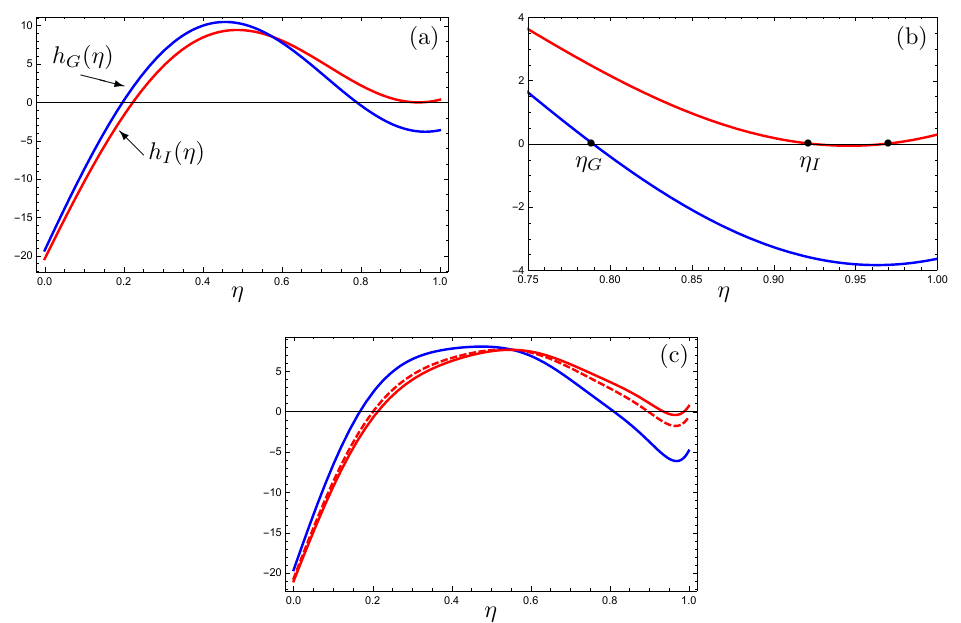
Figure 2. Plots of h G (blue) and h I (red), where the diffusion coefficients satisfy D G < D I . ( a , b ) N = 1, D G = 0.3, D I = 0.394; ( c ) N = 3, D G = 0.3 (blue), D I = 0.394 (dashed), D I = 0.43 (red,